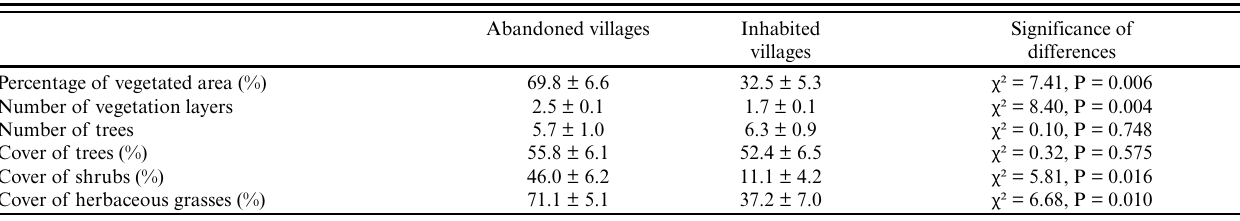
Table 1 . Differences in vegetation variables between abandoned and inhabited villages in the Huaibei coal mining area in the North China Plain.